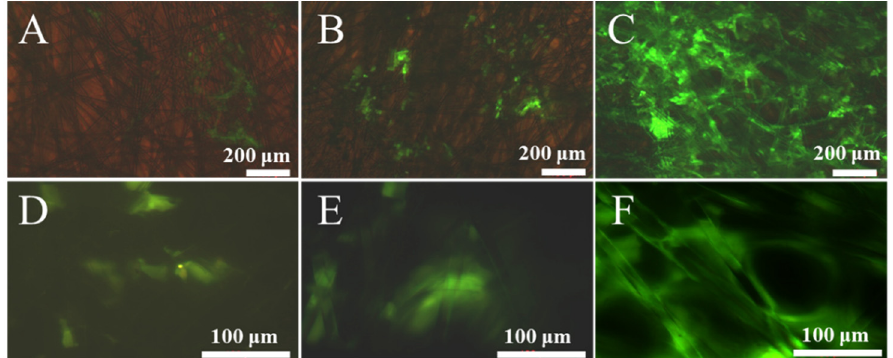
Figure 6. The appearance of PLLA-SH1 ( A , D ), PLLA-SH3 ( B , E ), and PLLA-SH5 ( C , F ) under a fluo-